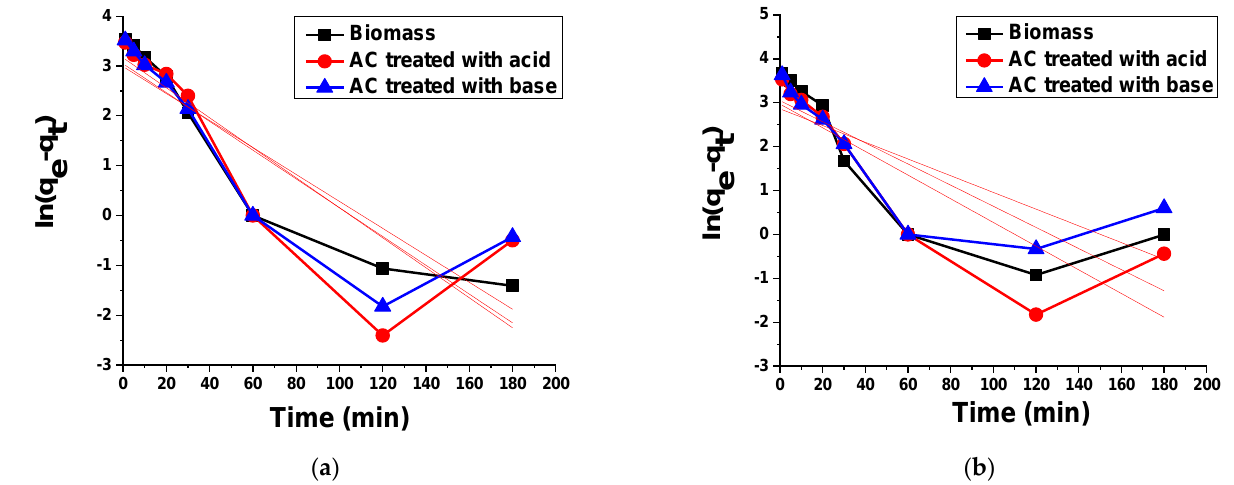
Figure 9. Pseudo-first order kinetic plots for the adsorption of ( a ) TB and ( b ) XO on biomass and AC treated with acid and base.